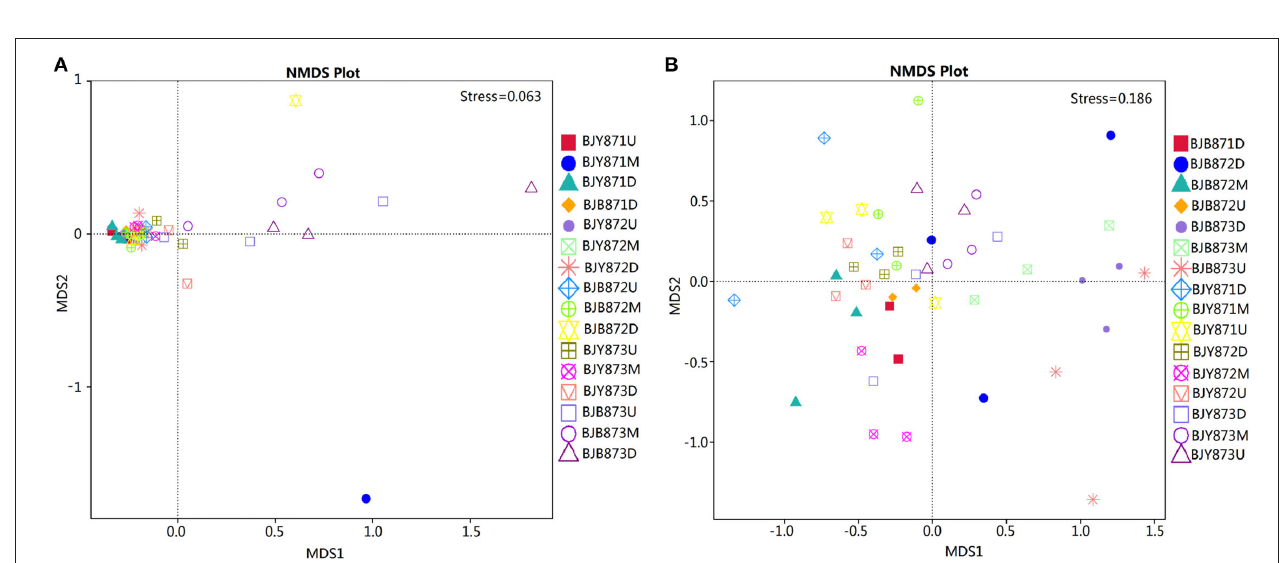
FIGURE 5 | Pie charts showing the relative abundance of top 5 bacterial genus of Pseudomonas, sphingomonas, Pantoea, Ralstonia, Kosakonia, and “others” in the three analyzed leaf positions and at three collecting time.